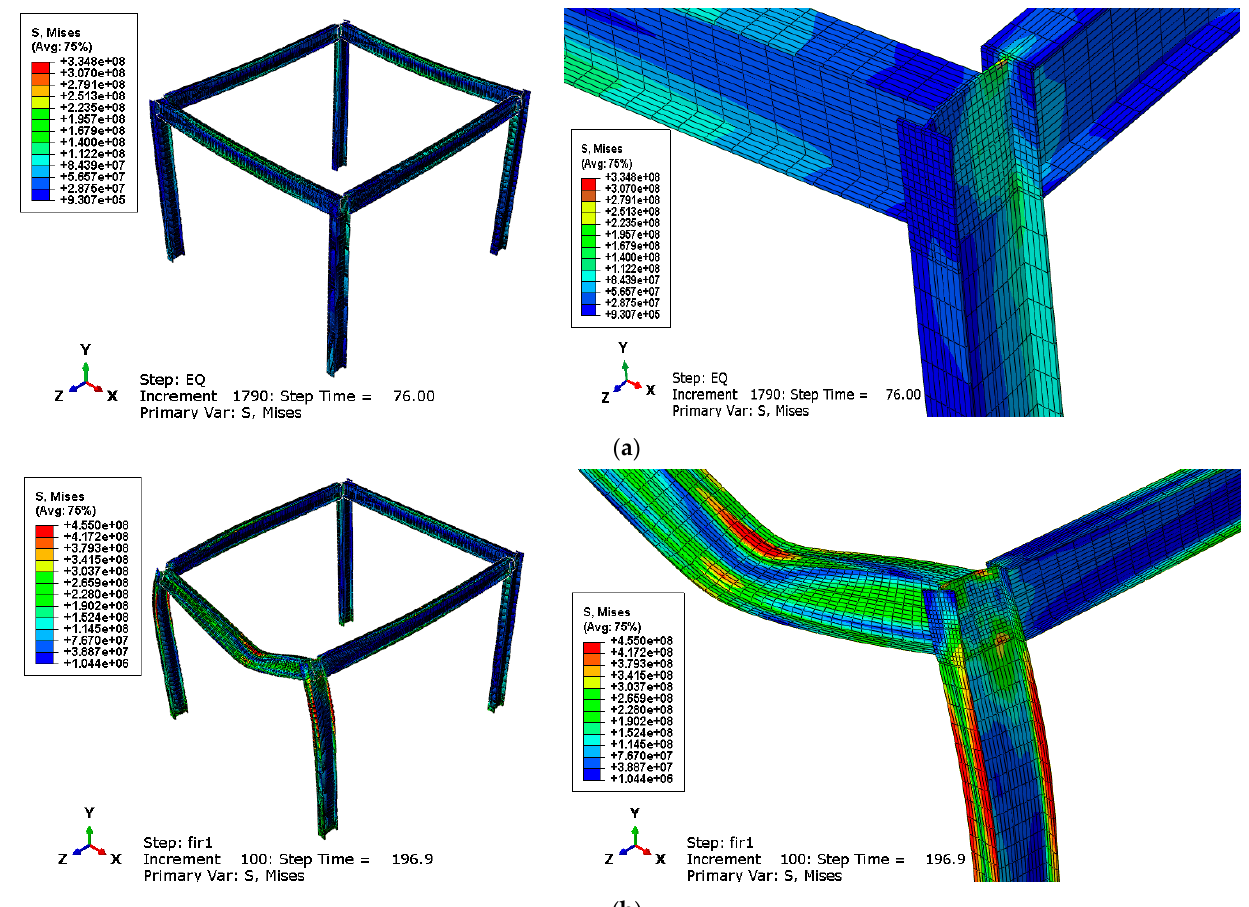
Figure 10. Images from a Case I PEF analysis with an artificial earthquake (PGA = 0.35 g, natural period = 0.16 sec), one-directional excitation in the z-direction including ( a ) the residual deformation of the structure at the end of earthquake event and ( b ) the shape and mechanism of failure of the structure after the PEF event.